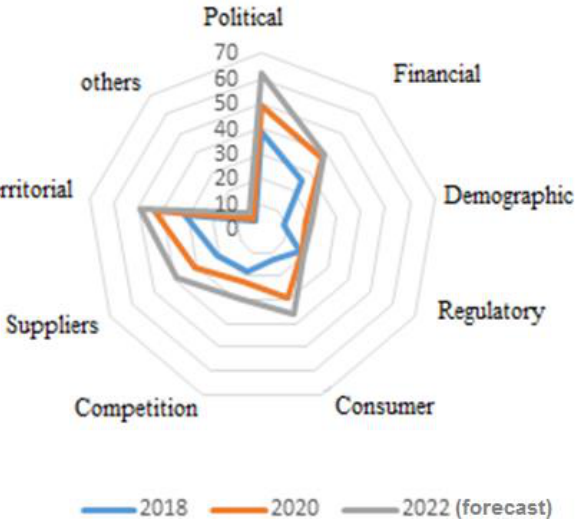
Figure 7. The results of the assessment of the group of global risks of the enterprises of the cluster. Developed by Leontyev E.